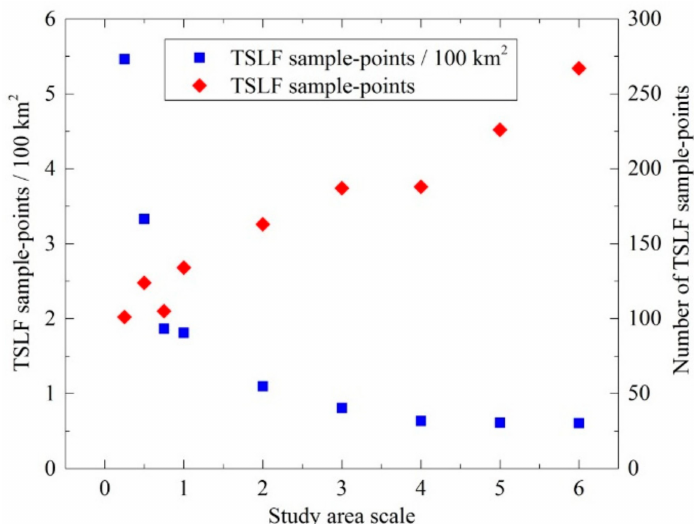
Figure 13. The minimum number of TSLF sample-points, and the density of TSLF sample-points per 100 km 2 , which were obtained for each of the nine study area scales. The number of TSLF points at each scale is the 95th percentile from the 201 TSLF maps, each of which in turn is represented by the 95th percentile of their 1000 trials of how many TSLF samples were required to meet an ADMM of